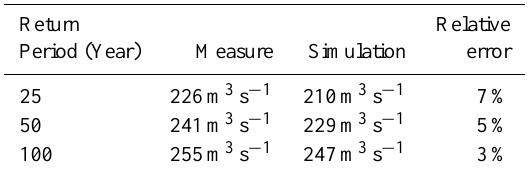
Table 3. Characteristic discharges at Chaudfontaine derived from observations and from